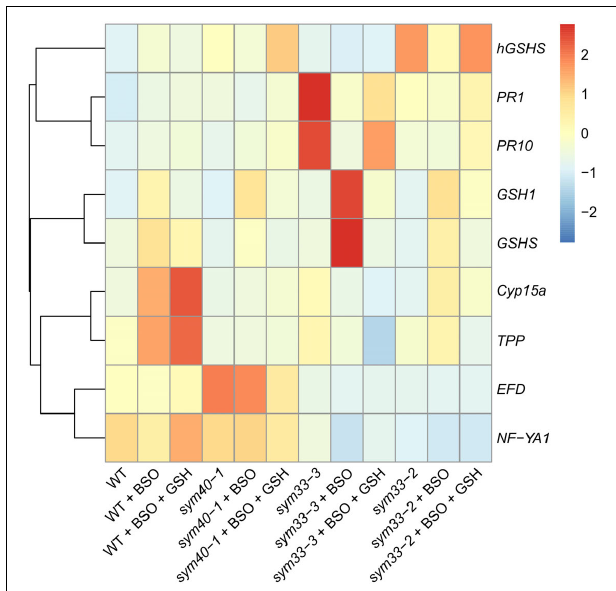
FIGURE 7 | Heatmap showing relative gene expression levels in 2-week-old roots with nodules from wild-type and mutant pea ( Pisum sativum ) plants treated with L-buthionine-sulphoximine (BSO) and glutathione (GSH). Transcript levels were determined by real-time PCR and calculated using the (cid:49) CT method with glyceraldehyde-3-phosphate dehydrogenase ( GAPC1 ) serving as the reference gene. The color scale shows relative expression values for each gene after Z -transformation. The heatmap is based on data presented in Supplementary Table 3 (list 1). Gene expression levels were compared using one-way ANOVA, a P -value < 0.05 was considered significant [see also Supplementary Table 3 (list 2)].